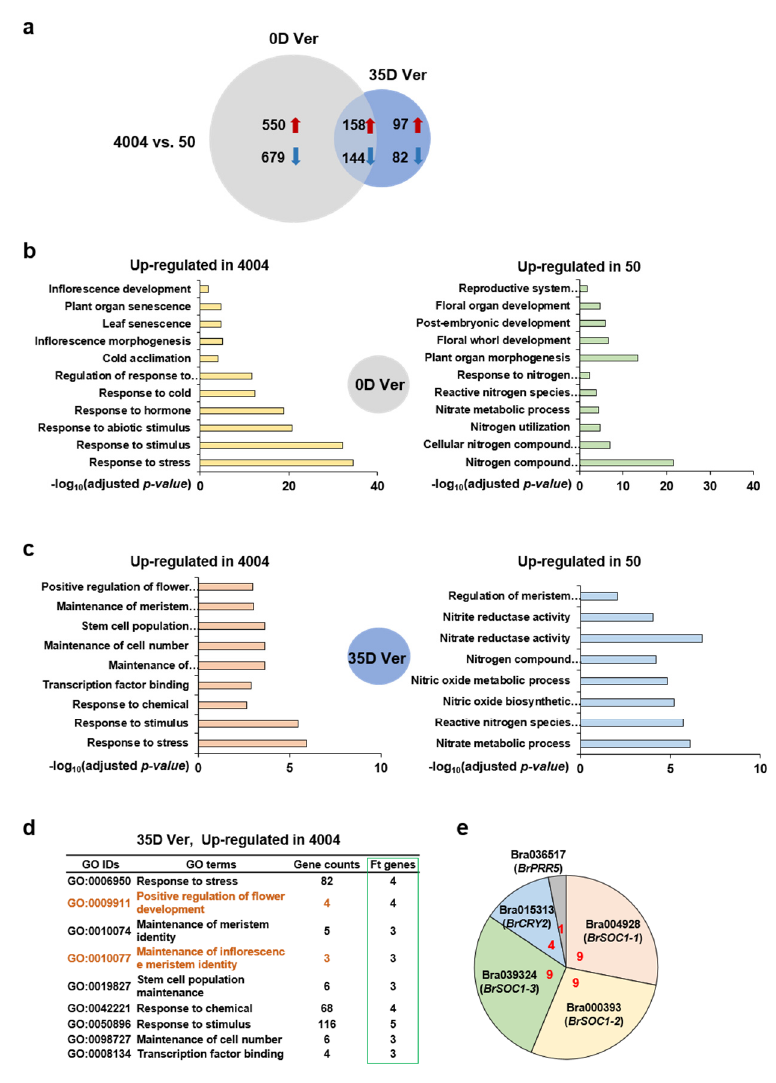
Figure 2. Bioinformatic analysis of RNA-seq data comparing lines “4004” and “50” grown with or without vernalization. ( a ) Differentially expressed genes (DEGs) were detected by comparing “4004” and “50” at each vernalization time point (0D Ver, 0 days vernalization; 35D Ver, 35 days with vernalization). Red arrowheads indicate up-regulated DEGs; blue arrowheads indicate down-regulated DEGs. ( b , c ) Gene ontology (GO) enrichment analysis of up- or down-regulated DEGs in “4004” vs. “50” (up-regulated DEGs in “50”) under 0D Ver conditions ( b ) and 35D Ver conditions ( c ). The most enriched GO terms are shown (adjusted p -value < 0.05). ( d ) Identification of flowering time genes derived from GO terms up-regulated in “4004” under 35D. The orange font represented GO trems of flowering pathway-related genes. ( e ) Circular graph distribution of flowering time (Ft) genes in Figure 2d. Red number means the number of GO pathways with Ft